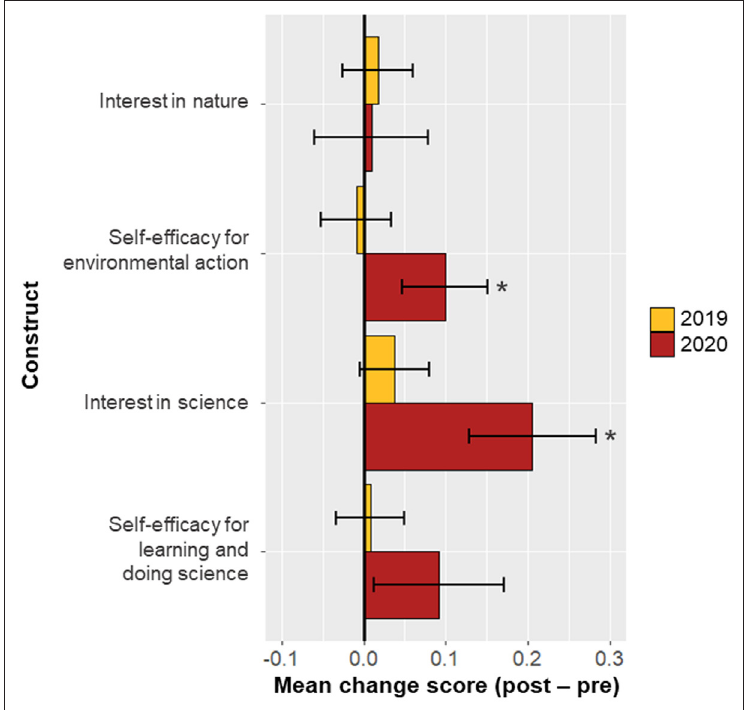
Figure 2 Mean change scores (post-score minus pre-score) by year across all student majors following citizen science participation. In 2019, students (n = 131) had no assignment choice; in 2020, students (n = 65) had a choice of three assignments. Change scores shown for all four constructs of interest. Scores above 0 denote positive change. Asterisk (*) denotes statistical significance of score change for a construct based on factorial ANOVA at p = 0.1. Error bars represent standard error of the mean change